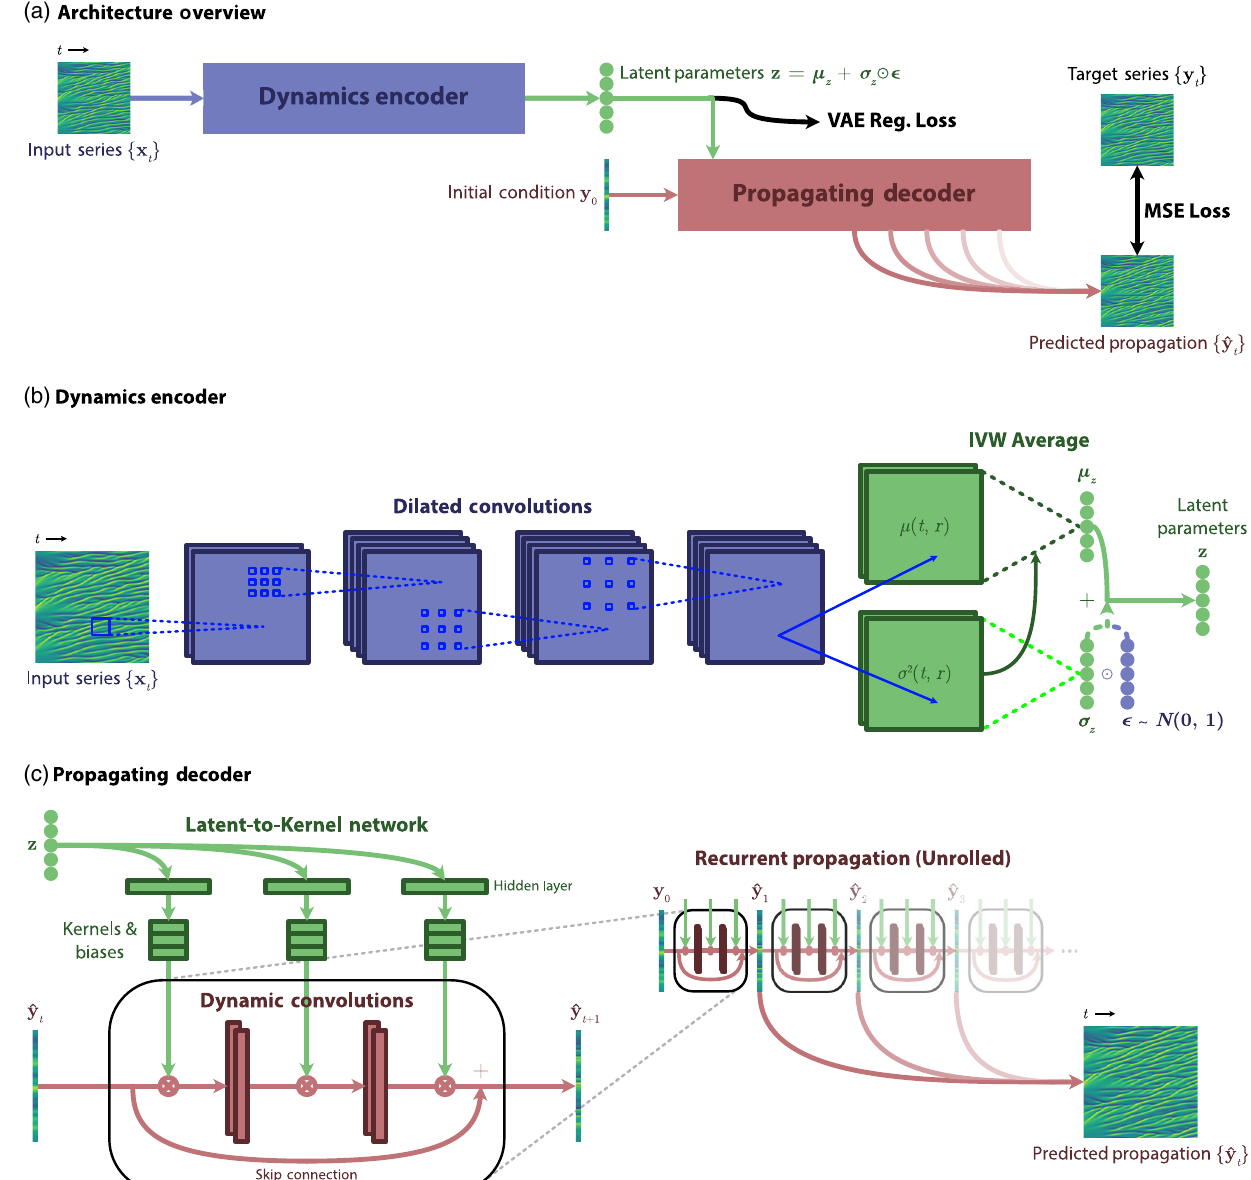
FIG. 1. VAE-based model architecture. (a) The architecture consists of the dynamics encoder (DE) and the propagating decoder (PD) with kernels and biases given by a latent-to-kernel network. (b) The DE extracts the latent distribution parameters μ and σ from the z z T x using dilated convolutions and inverse-variance weighted (IVW) averaging. During training, the latent parameters input series f x t g t ¼ 0 ; σ 2 . (c) The PD then uses a fully connected latent-to-kernel network to map the are sampled from the extracted distribution z ∼ N ð μ z Þ z latent parameters z to the kernels and biases of the dynamic convolutional layers, which are used in a recurrent fashion to predict the T y y propagation of the system f ˆ y starting from the initial condition ˆ y 0 . The model is trained end to end using the mean-squared t g 0 ¼ t ¼ 1 T y T y error (MSE) loss between the predicted propagation series f ˆ y and target series f y along with VAE regularization. Time-series t g t g t ¼ 1 t ¼ 1 limits are dropped in the labels for